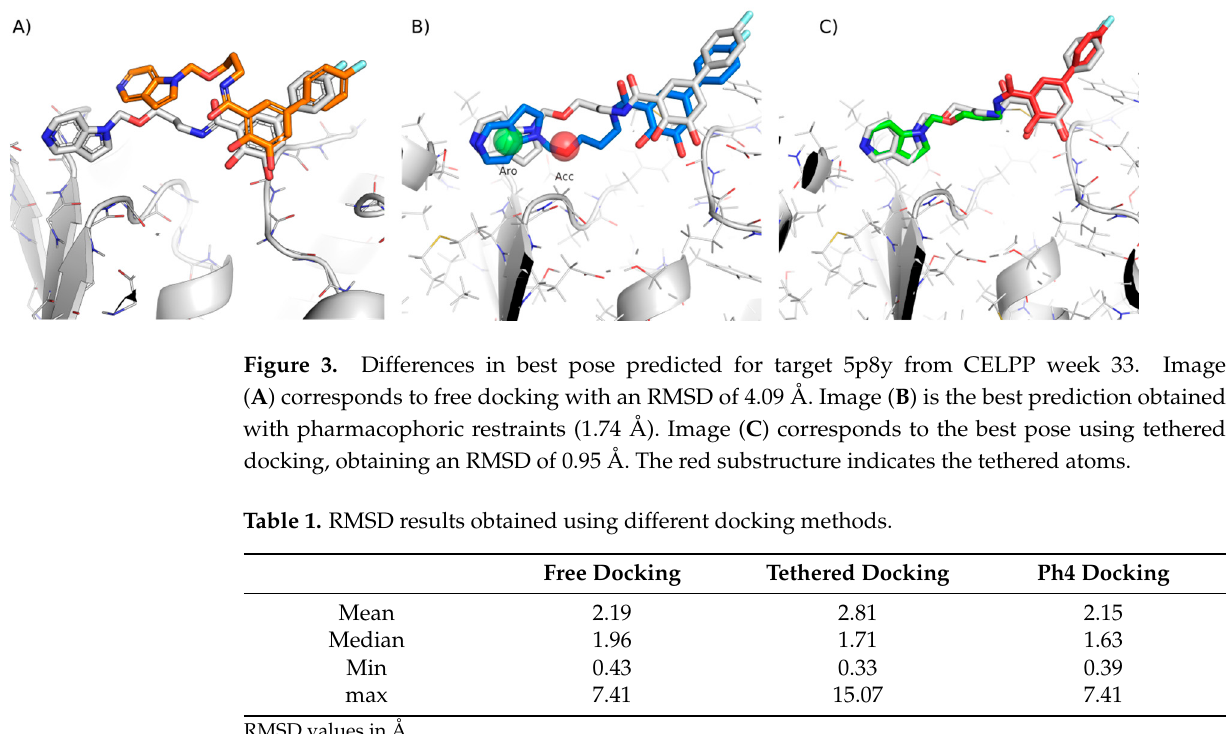
Figure 4. Relation between RMSD and the MCSS score using ( A ) the test set and ( B ) the validation set. Free docking results shown in red, docking with pharmacophoric restraints in green (version 1) and yellow (version 2; only applied to the validation set) and MCS-tethered docking in blue.